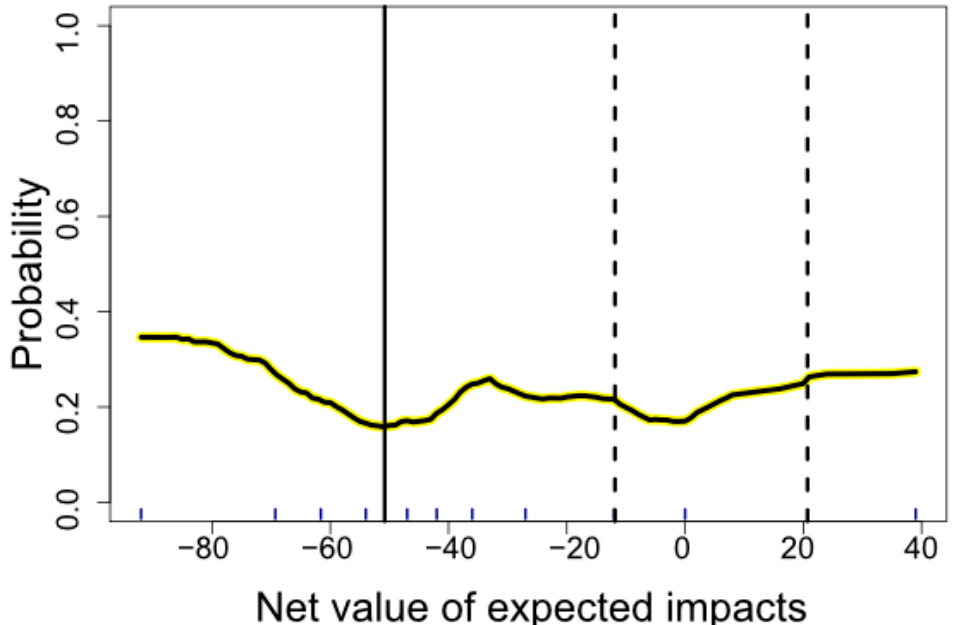
Figure 2. The equivalent of expected utility from decisions in favour of adaptation. A BART model was constructed for the probability of decision-making promoting adaptation based on the net value of expected impacts . Probabilities were taken as equivalents of the utility expected from decisions in favour of adaptation (see Figure S1 and Table S2). Breakpoints for negative tipping point behaviour of two kinds are shown as lines below which the two kinds of tipping point behaviour can occur. ‘Decision maker ´ s tipping point behaviour’ is shown as a dashed line and ‘Systemic tipping point behaviour’ as a full